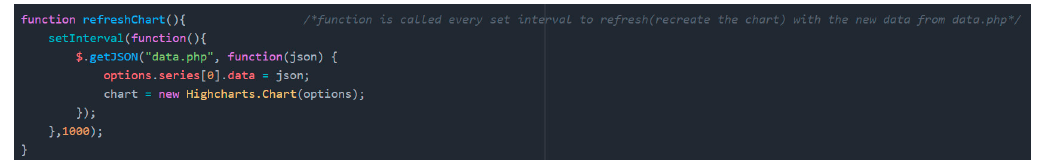
Figure 12. The chart refresh function.